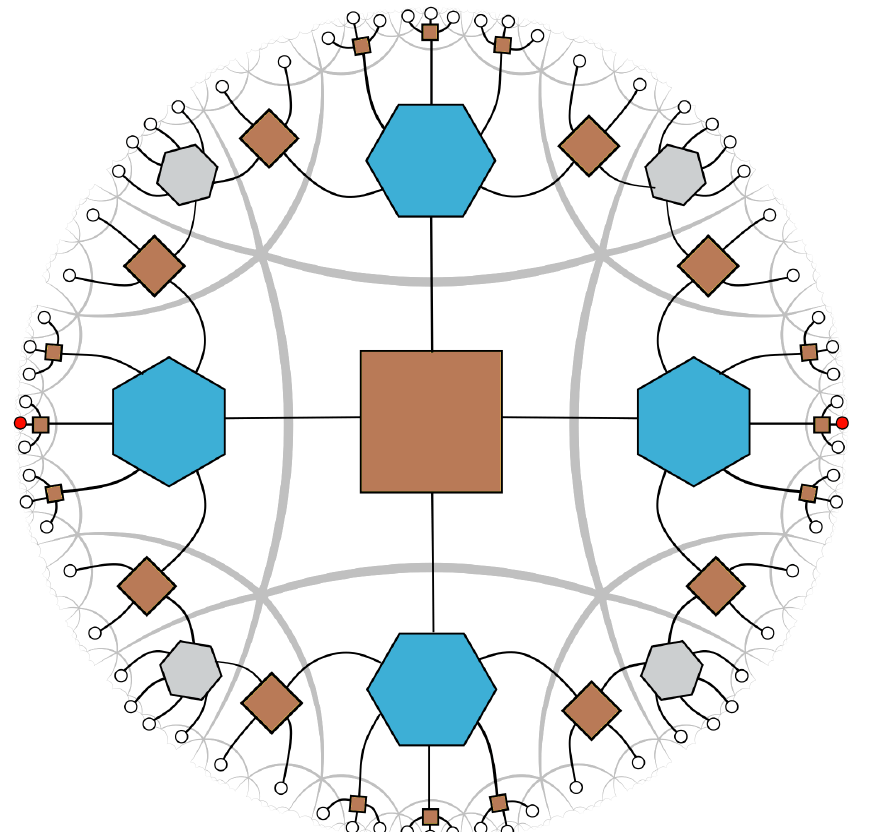
Figure 46. It is understood that the tensor network is the dual graph and red markers are X ⊗ X in the double copy. We can alternate the perfect tensor (grey) and imperfect tensor (blue) tiles such that the tensor network can be efficiently contracted while having power-law for certain two-point operator